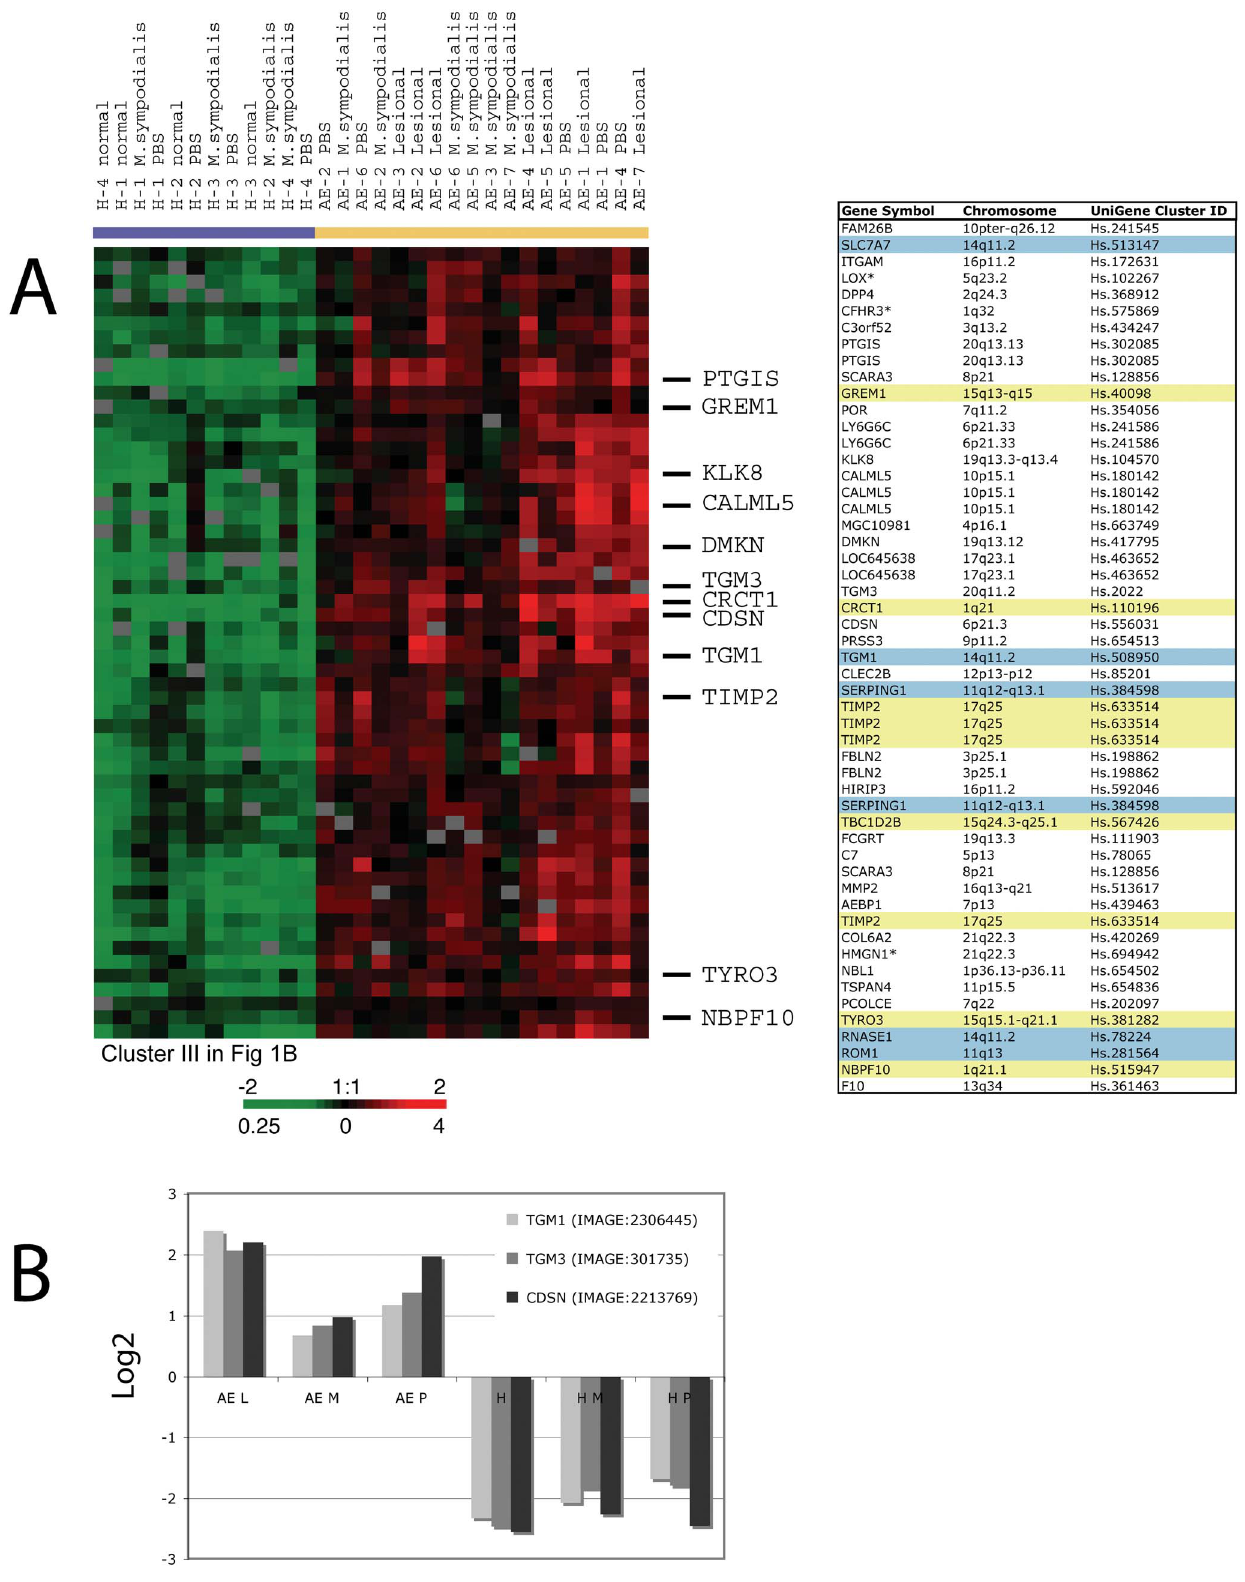
Figure 6. Genes involved in skin barrier function differentially expressed in skin from AE patients as compared to healthy control individuals. (A) A zoomed in picture of the hierarchical cluster analysis illustrating genes involved in skin barrier function that were found coordinately over-expressed in AE skin as compared to healthy skin (left). A detailed list of the genes represented in this cluster is shown in the table (right). Genes localized in genome-wide linkage eczema regions or an AE associated loci are highlighted in blue and yellow, respectively. (B) Members